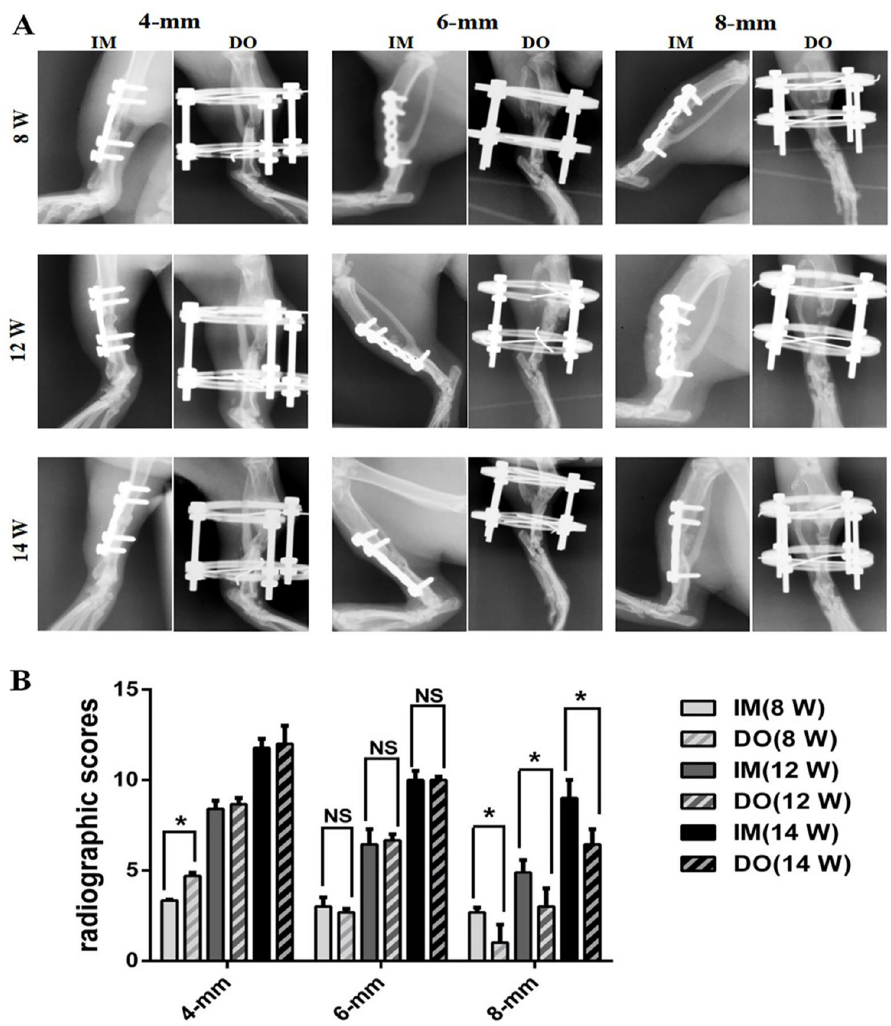
Fig 2. Radiological evaluation of bone repair in 4-,6- and 8-mm groups at 8, 12 and 14 weeks after surgery, respectively. (A) Series of representative radiographs of bilateral tibias treated with IM and DO. (B) Quantitative analysis of radiological scores. Significant difference is present when P < 0.05 and displayed with an asterisk; NS: not